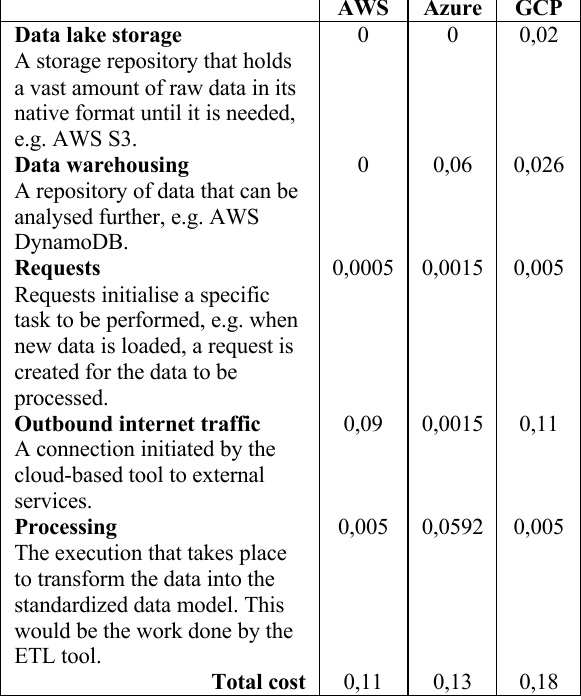
Table 1. Estimated cost in US dollars per month per GB